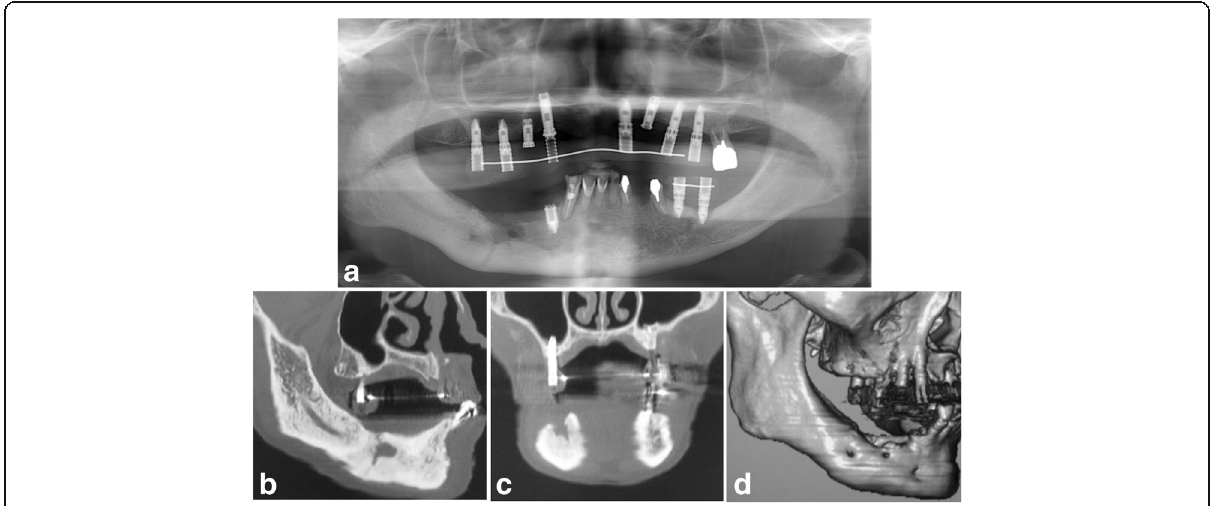
Fig. 6 a Panoramic radiograph 16 months after the sequestrectomy. b Sagittal CT view. c Coronal CT view. d 3D CT